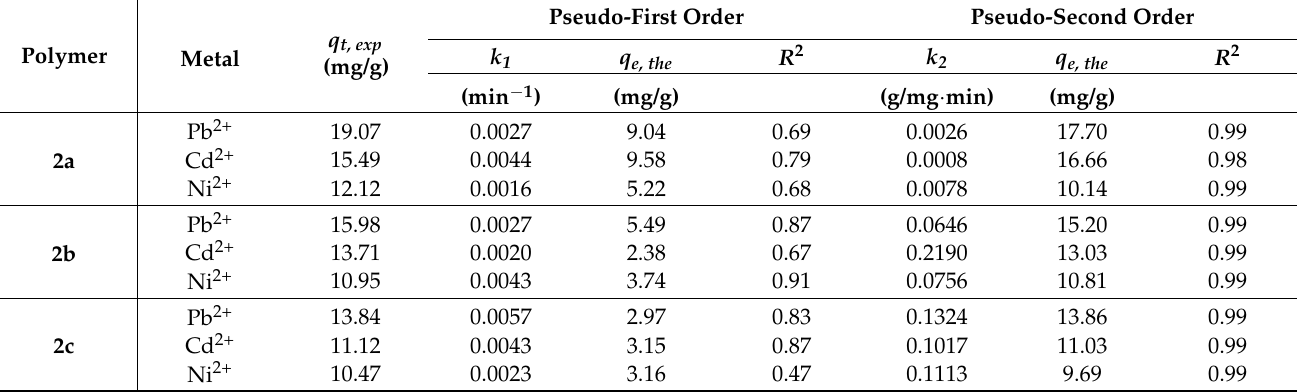
Figure 7. Amount of heavy metal uptaken by the polymers 2a , 2b and 2c as a function of time ( t ). Table 2. Kinetic parameters of the heavy metal uptake by the thiol ‐ functionalized polymers.